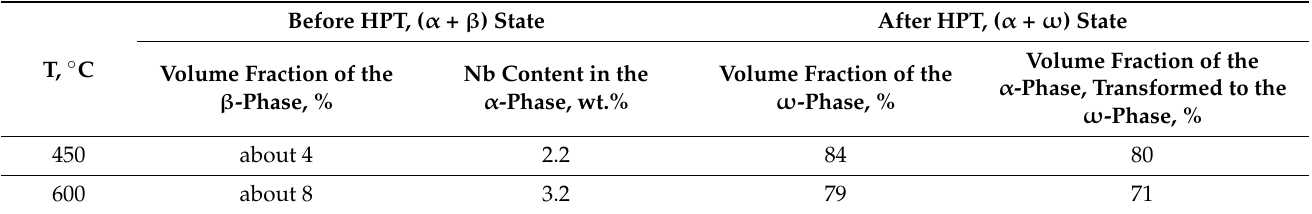
Table 2. Volume fraction of some phases before and after HPT as well as Nb content in the α -phase in the initial